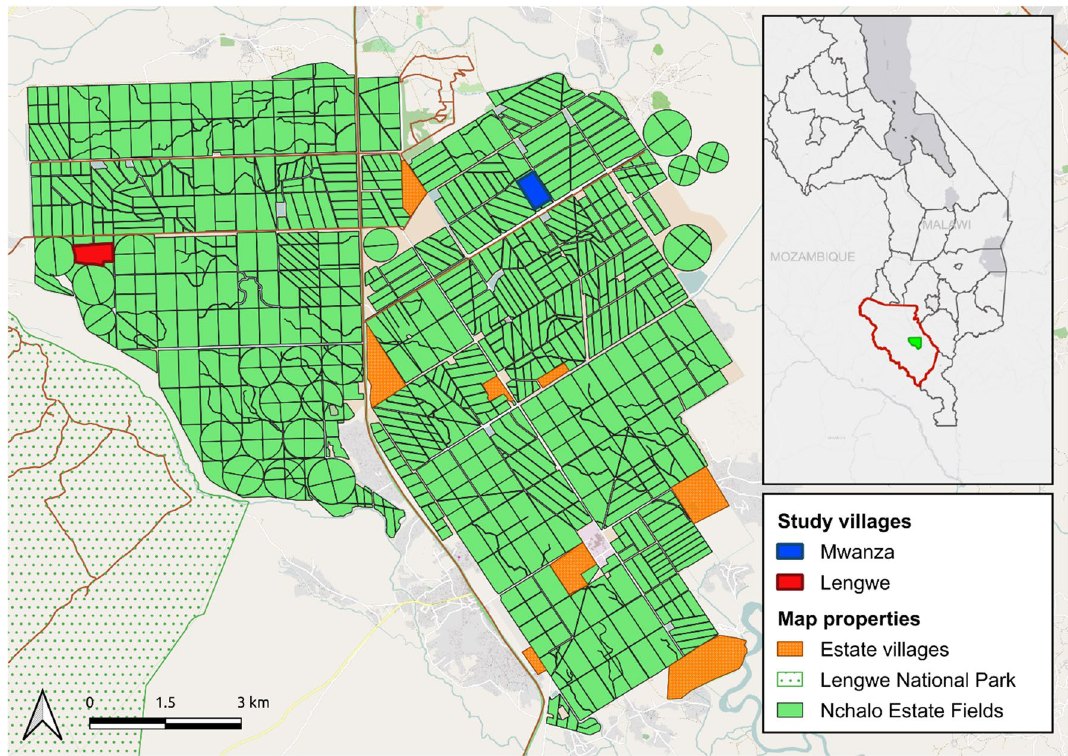
Figure 4. The location of the Illovo sugar estate within Malawi (inset) and study villages Mwanza and Lengwe. Map created using QGIS version 2.18 (https:// qgis. org/ en/